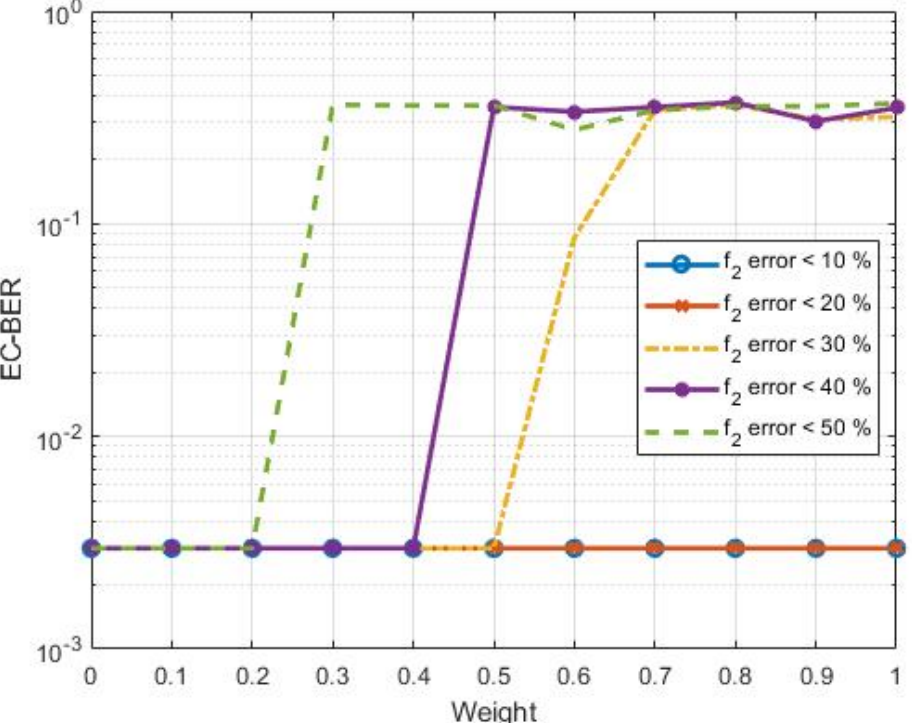
Figure 4. EC-BER for various weighting values.